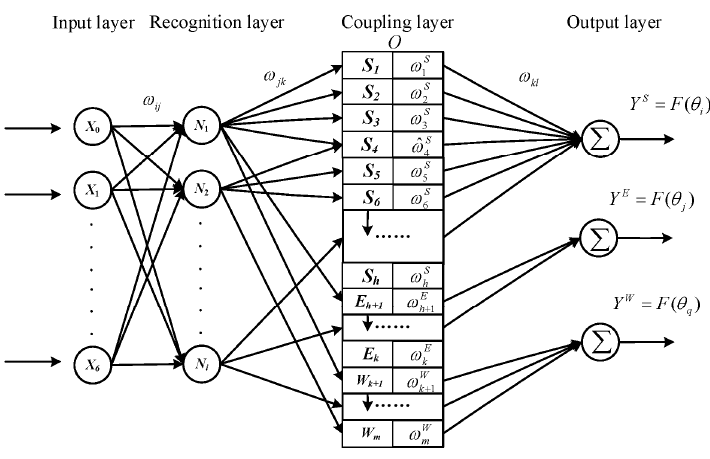
Figure 7. The structure of CPNN. Table 3. The active state of hidden neurons.